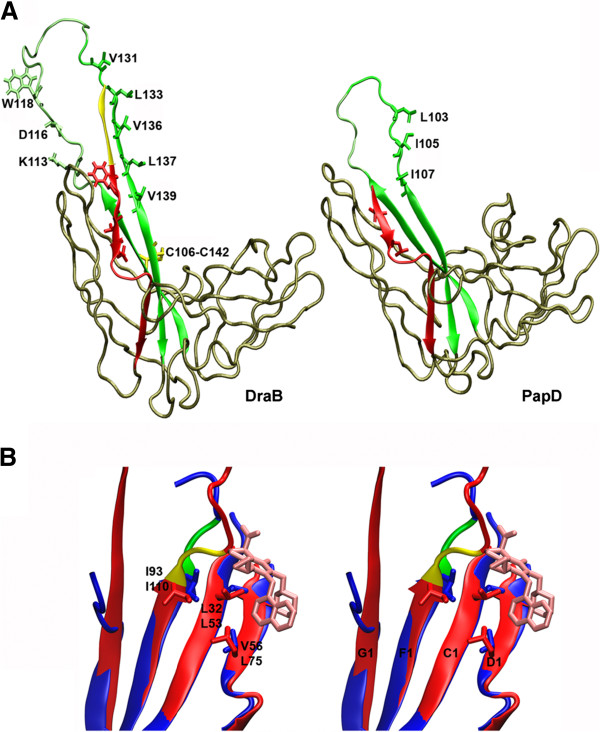
DraB as a model of the FGL subfamily of chaperones. (A) Characteristic elements of the DraB structure (PDB ID: 4DJM) specific to the FGL chaperones in relation to the PapD (PDB ID: 2WMP), - the representative of the FGS subfamily. The part of β-strand A1 with hydrophobic residues participating in subunit interaction represented in the bonds mode is denoted in red. The fragment of the long N-terminal region of the β-strand A1 characteristic for FGL chaperones observed in the DraB is denoted in yellow. The F1 strand-loop-G1 strand hairpin motif is denoted in green with the alternating hydrophobic residues of the β-strand G1 participating in the DSC reaction denoted in the bonds mode. In the F1-G1 loop of the DraB protein, the conserved residue motif KDW characteristic for FGL chaperones are marked with the bond mode. The disulfide bond binding β-strands F1 and G1 in the DraB structure conserved in the entire FGL subfamily is marked in yellow bond mode. The F1-G1 loop region was modeled using MODELLER v9.2 software. (B) Structural alignment of the usher binding site of DraB (red) and PapD-pilicide (PDB ID: 2J7L) (blue) with denoted hydrophobic patch that includes I93, L32, V56 (PapD) and I110, L56, L32 (DraB) residues forming pilicide (pink) binding motif. At the beginning of the F1-G1 loop the region of two proline residues forming “proline lock” conserved in the family of chaperones is denoted (P111 and P112 in the DraB – yellow; P94 and P95 in the PapD - green).